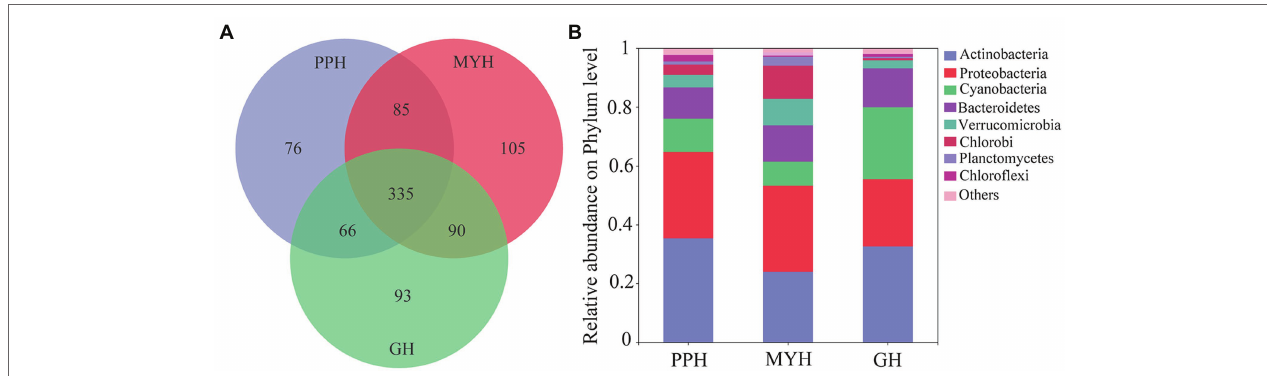
FIGURE 2 | Bacterial community compositions in water samples in PPH, MYH, and GH. (A) Venn diagram showing the operational taxonomic units (OTUs) number in the three lakes and (B) the composition of the dominant bacterial phyla (with average relative abundance >1%) across the three lakes, where sequences that have a mean relative abundance <1% were assigned to